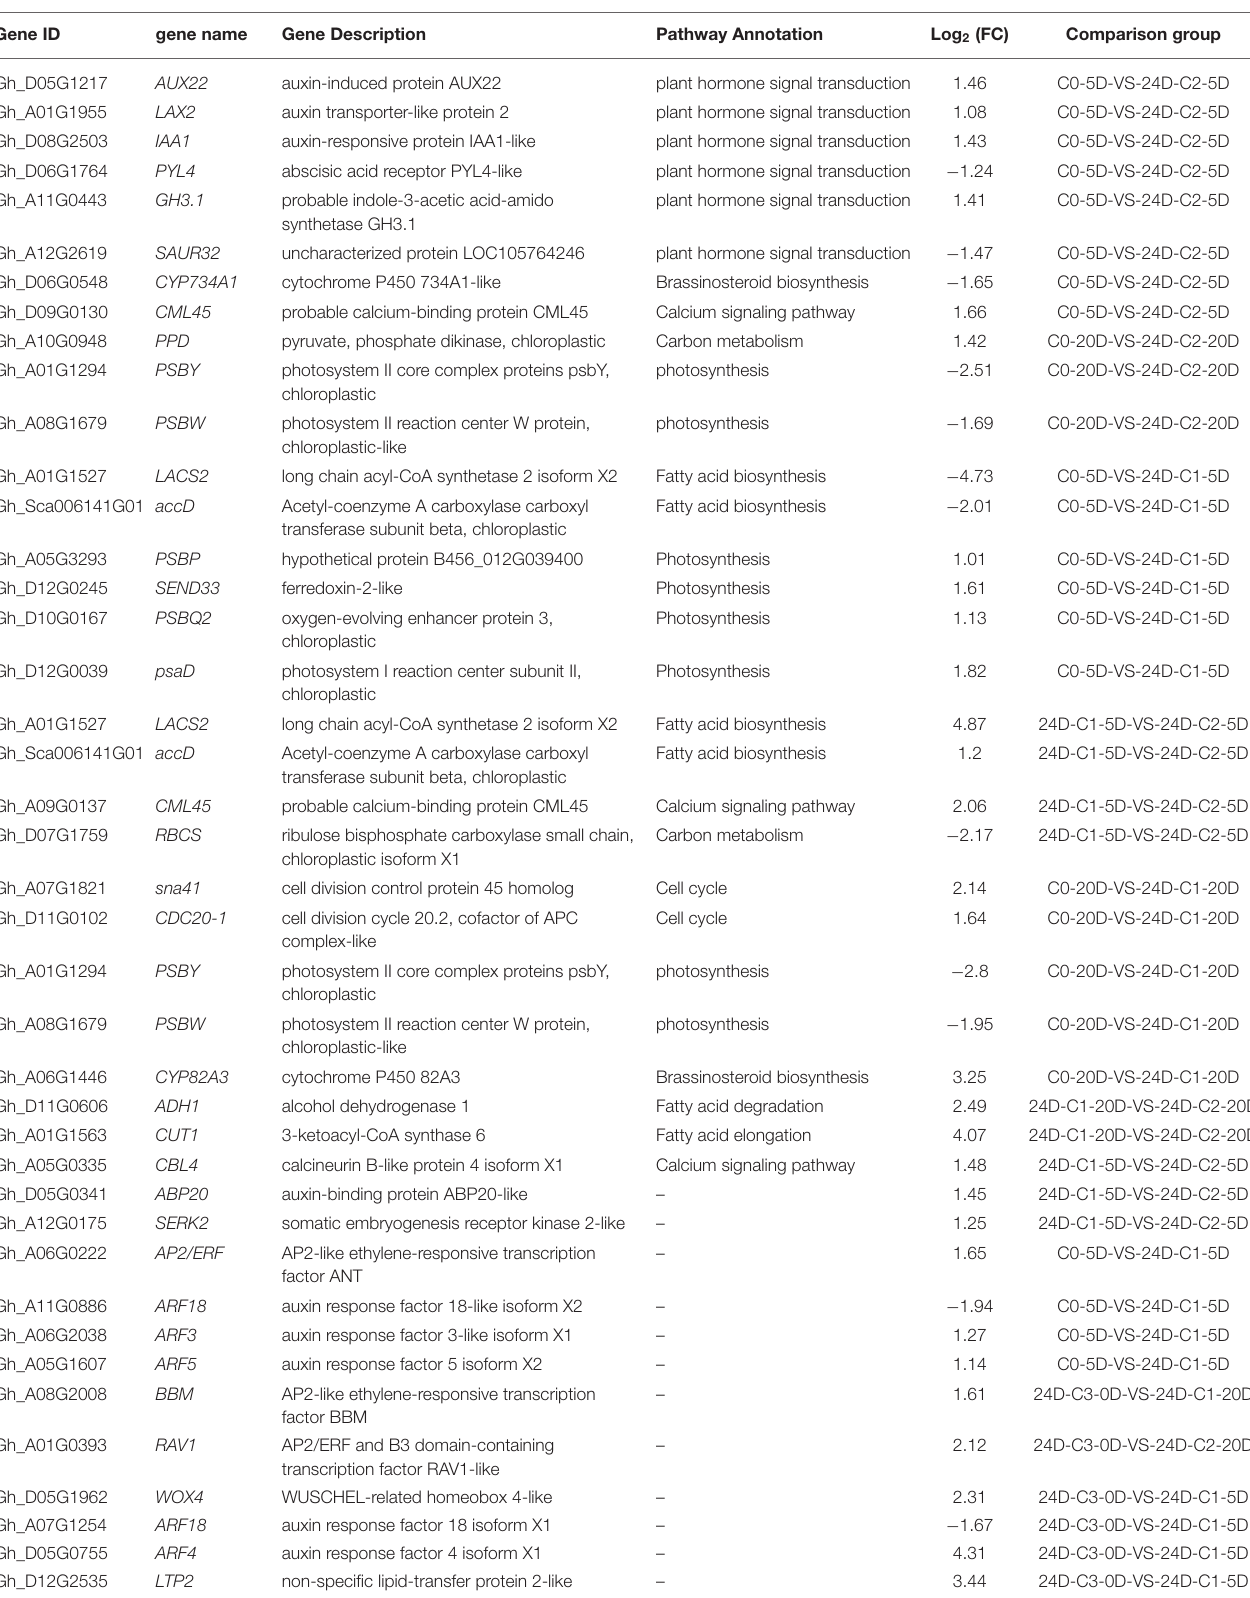
TABLE 4 | Representative DEGs induced by